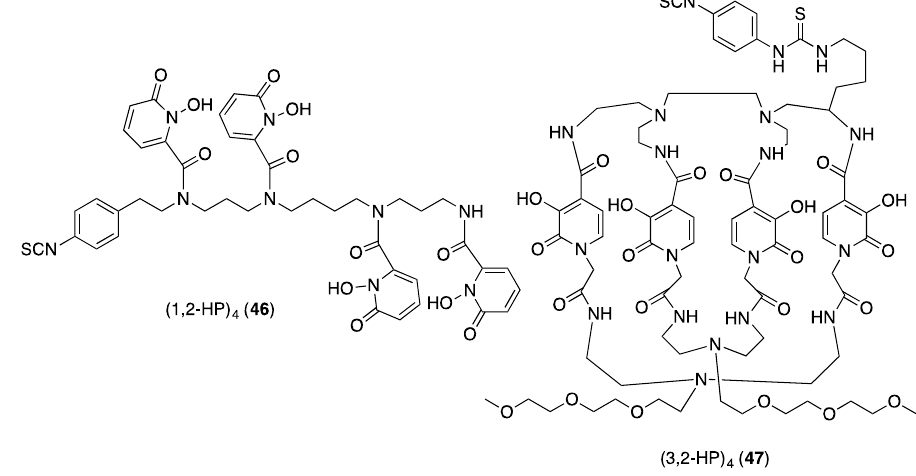
Figure 16. Structures of octadentate (HP) 4 derivatives evaluated for 89 Zr 4+ immunoconjugate radiolabelling. Bifunctional macrobicyclic octadentate (3,2-HP) 4 ( 47 , Figure 16) has also been derivatised